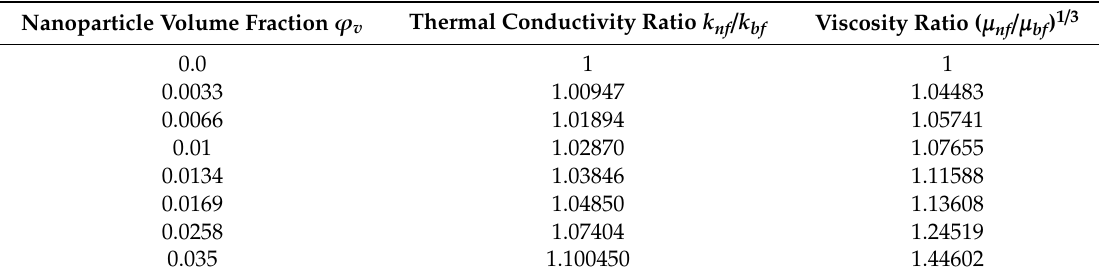
Table 5. Performance evaluation of the EG-Si 3 N 4